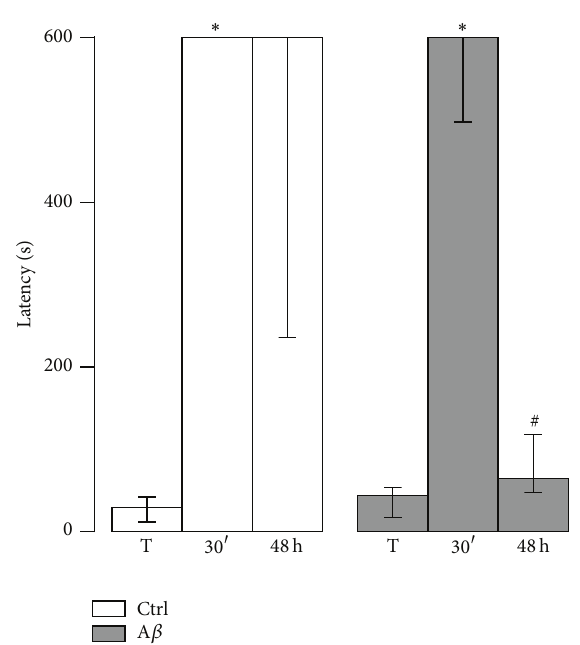
Figure 3: A 𝛽 impairs memory consolidation but not learning. Training latencies (T) and retention latencies obtained 30 min (30 󸀠 ) and 48 h after training from control (Ctrl) or A 𝛽 (400 pmoles) groups ( 𝑛 = 10 rats/group). Data are presented as medians ± interquartile ranges. ∗ 𝑝 < 0.05 versus training latency. # 𝑝 < 0.05 versus 30 min retention